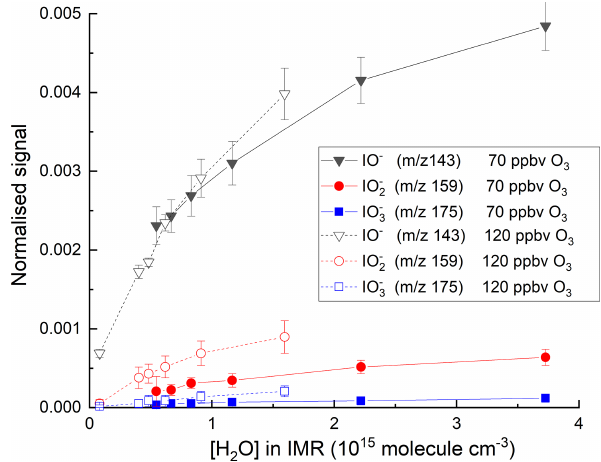
Figure 4. Variation in the total ion signal (counts) due to IO − , IO 2 − and IO 3 − with the concentration of water vapour in the IMR. The results are from two sets of experiments where the O 3 mixing ratio was either 70 or